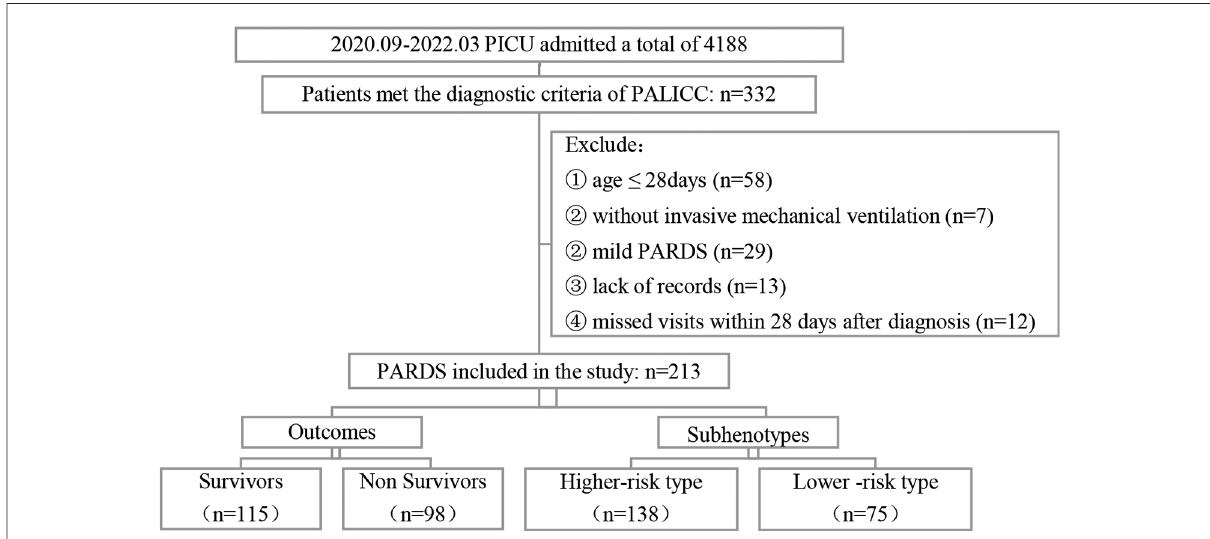
FIGURE 1 Flow chart of screening. PICU: Pediatric Intensive Care Unit; PALICC, Pediatric Acute Lung Injury Consensus Conference; PARDS: Pediatric Acute Respiratory Distress